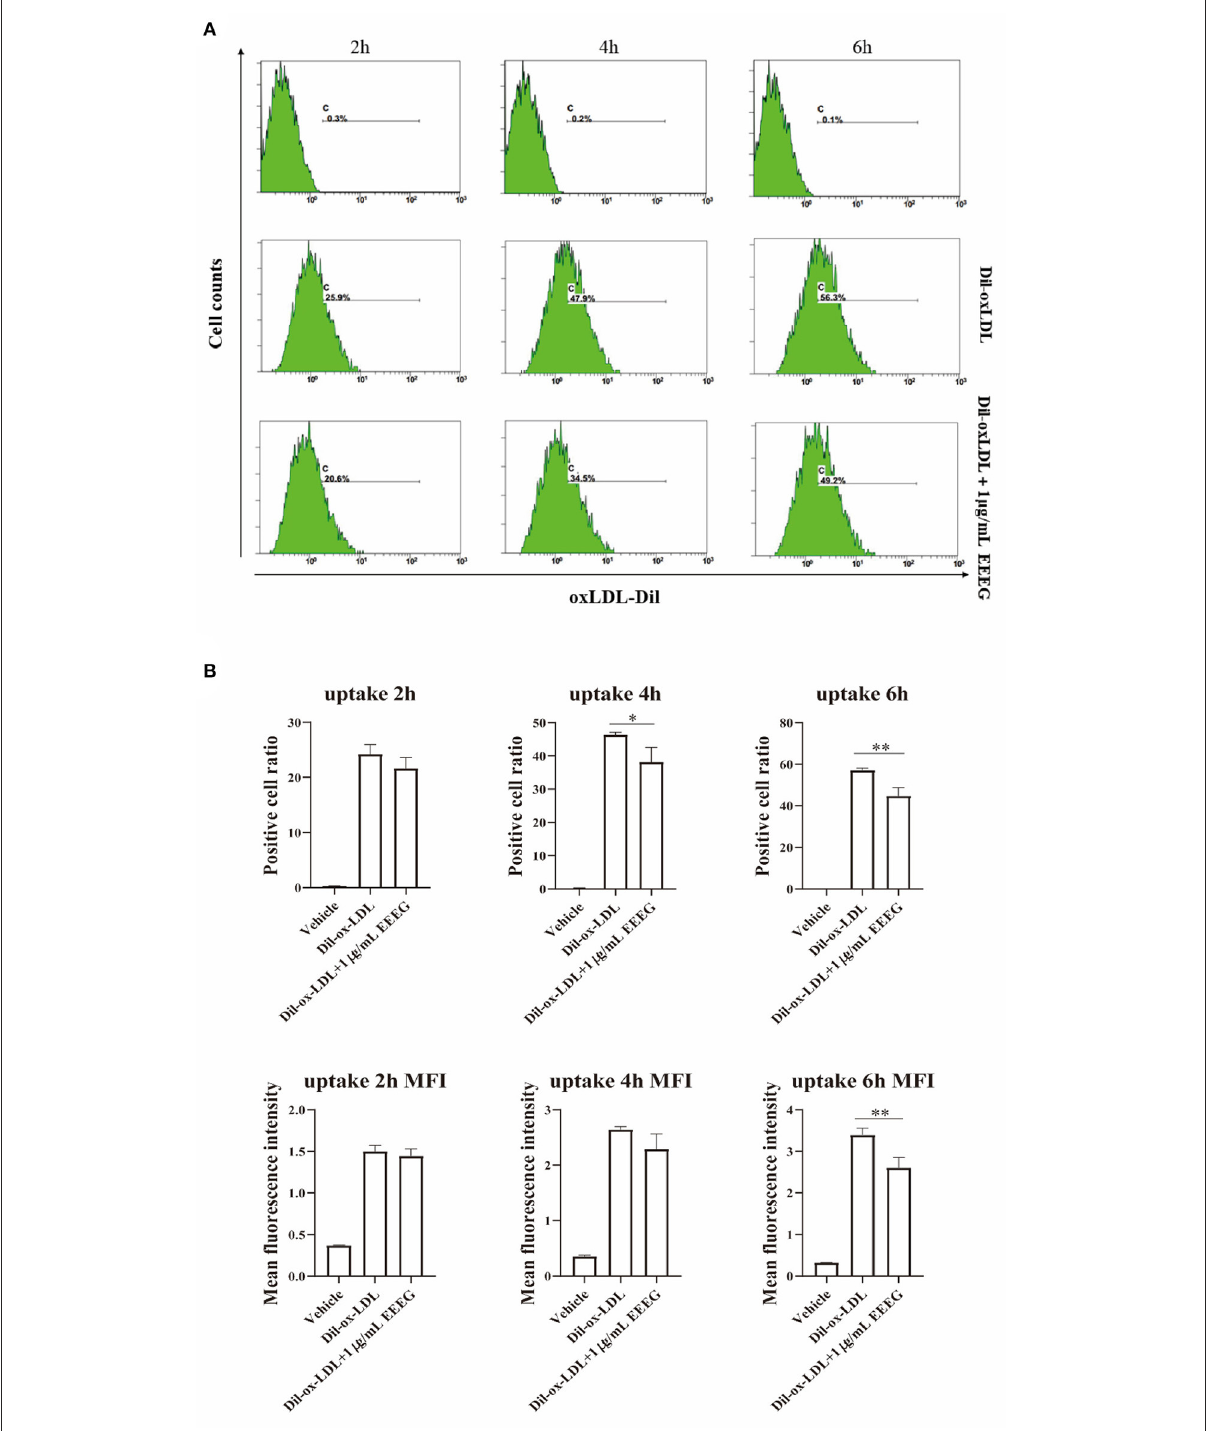
FIGURE3 EEEG inhibits the uptake of oxidized low-density lipoprotein by macrophages. (A) Representative histogram plots of Dil-ox-LDL binding by macrophages. Cells were incubated for 2, 4, and 6h with Dil-ox-LDL in the presence or absence of EEEG, followed by flow cytometry. (B) Quantification of the percentage of positive cells and mean fluorescence intensity values. DiI-ox-LDL-fluorescence is shown on the Y-axis and macrophage numbers on the X-axis. Data are expressed as mean ± s.e.m., Statistical analysis was based on Graphpad Prism 9.0.2 software and a value of P < 0.05 was considered statistically significant. One-way ANOVA with Student Neuman-Keuls post-hoc test was performed to compare the data between multiple groups, * p < 0.05, ** p < 0.01 vs.